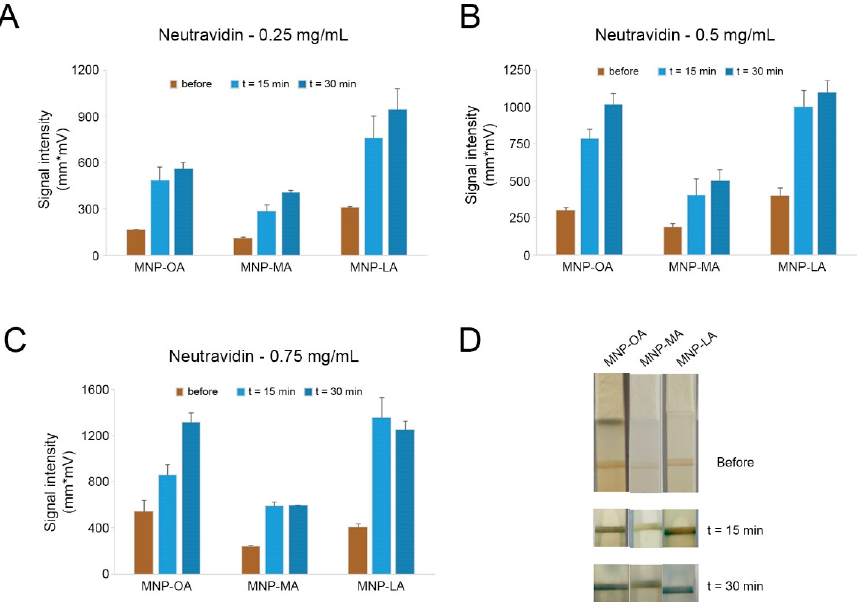
Figure 4. Effect over time of the peroxidase-like activity of MNP-OA, MNP-MA, and MNP-LA conjugated with three different concentrations of neutravidin: ( A ) 0.25 mg/mL, ( B ) 0.5 mg/mL, ( C ) 0.75 mg/mL. ( D ) Representative image of LFA strips at 15 min and 30 min using MNPs coated with 0.25 mg/mL of neutravidin as reporter label.